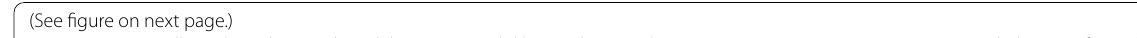
(See figure on next page.) Fig. 4 Magnetotelluric data (dots) and model response (solid lines). They are shown as apparent resistivity (Ap. Res.; ρ ) and phase ( φ ) from all impedance components (off-diagonal, xy and yx, left column; diagonal, xx and yy, right column) at six selected (representative) sites. The locations of the measurement sites are indicated in Fig. 1 (site names: 2310; 2360; 4295; 4343; 6310; 6350). Assigned error floors are shown as error bars (see text for details). In general, the models fit the